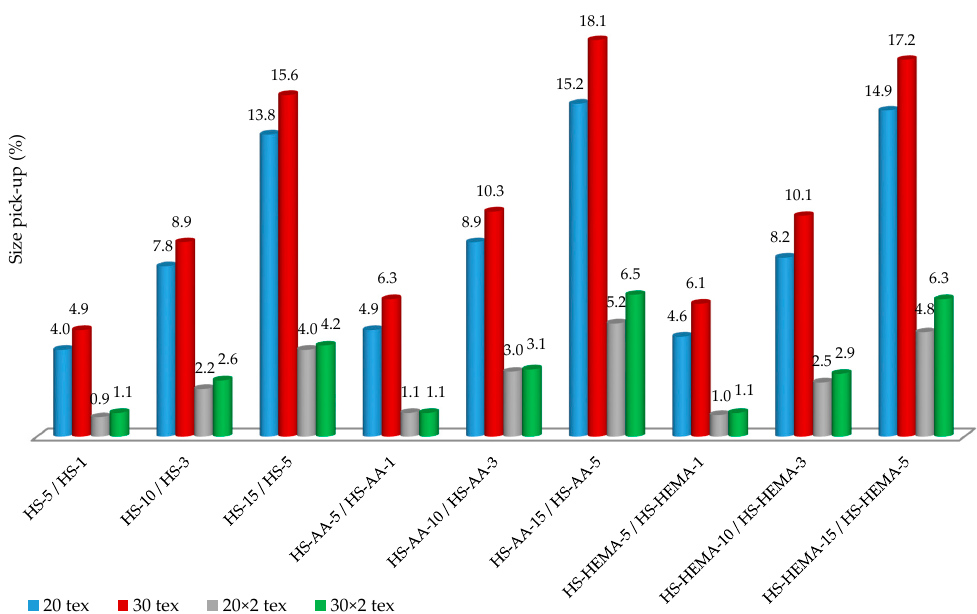
Figure 8. Size pick-up on the yarn sized with hydrolysed starch, then with the starch grafted with AA and HEMA monomers; explanation of designations: “HS-5/HS-1“: HS—hydrolysed starch, 5—concentration (5%), 1—concentration (1%).